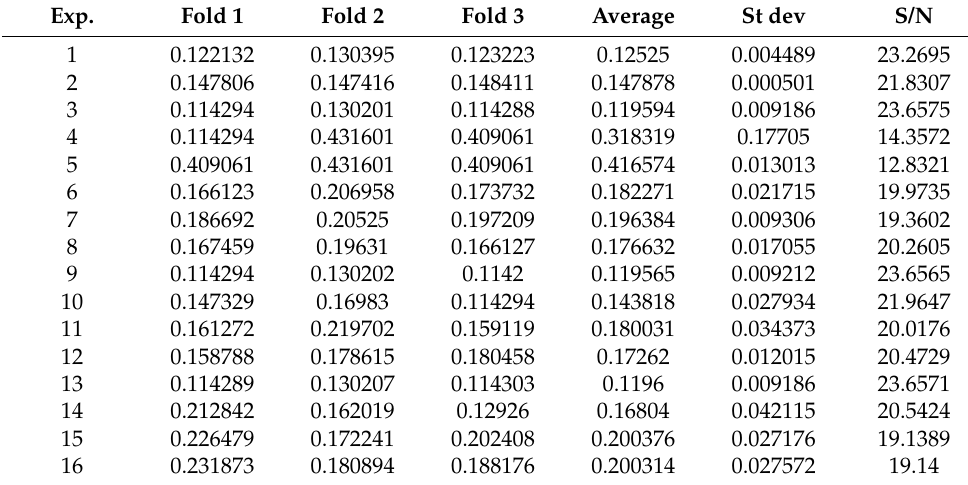
Table 8. Experiment error data.